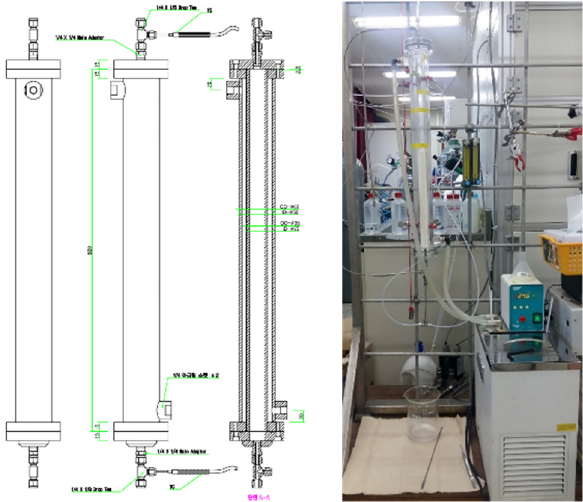
Figure 4. Schematic illustration of the column and a photograph of the experimental setup.